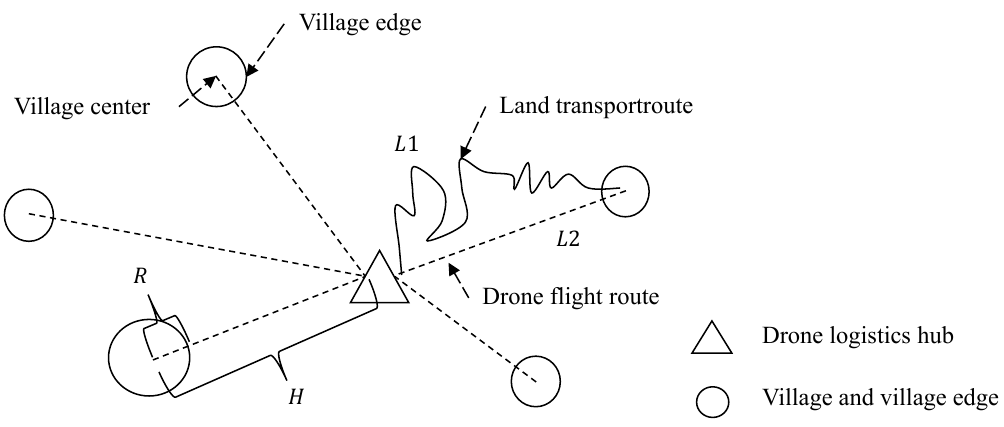
Figure 1. Location model of drone logistics